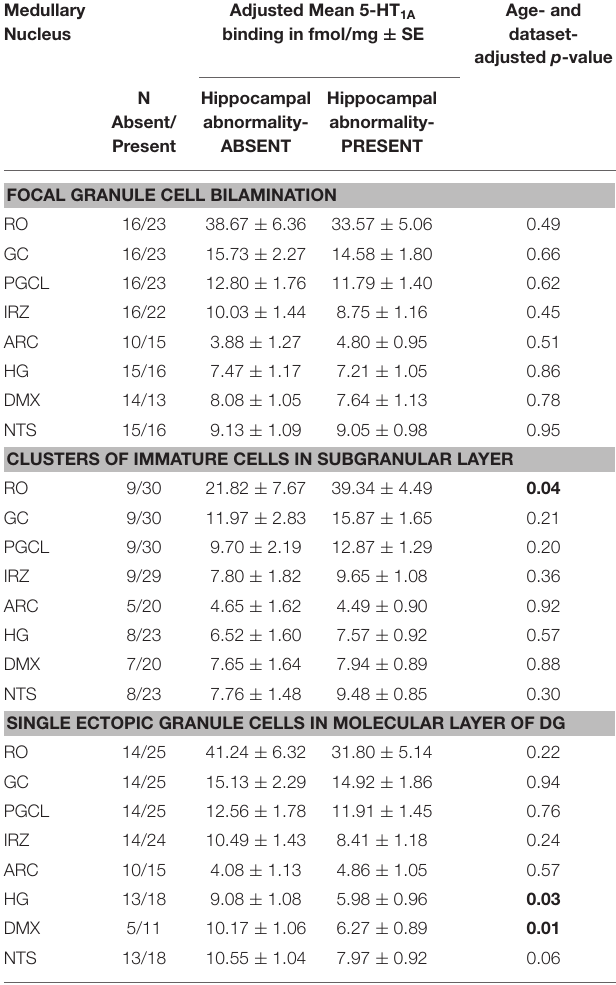
TABLE 5 | Medullary 5-HT 1A binding in SIDS cases with and without specific hippocampal Analytic cohort of SIDS cases with medullary